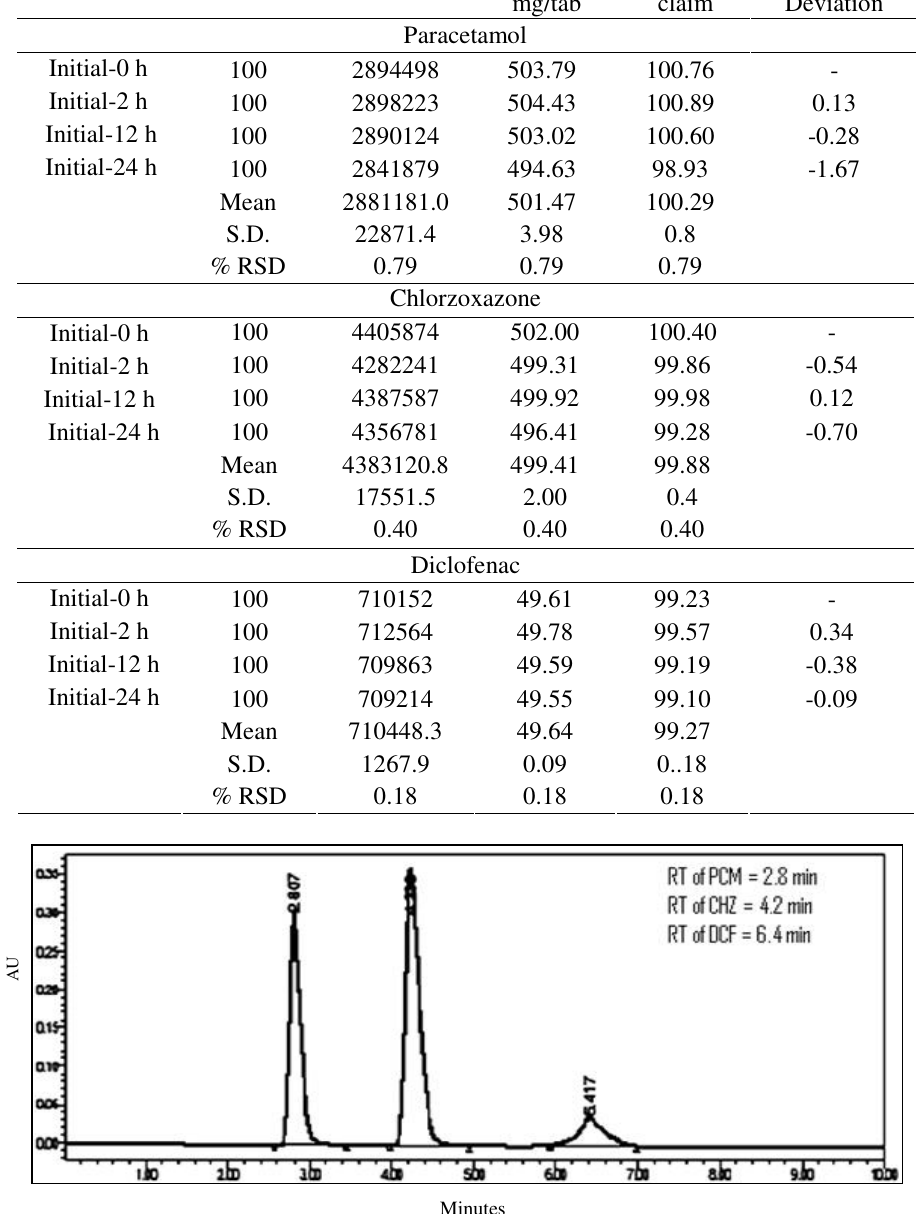
Table 2. Solution stability of paracetamol, chlorzoxazone and diclofenac sample solution Conditions